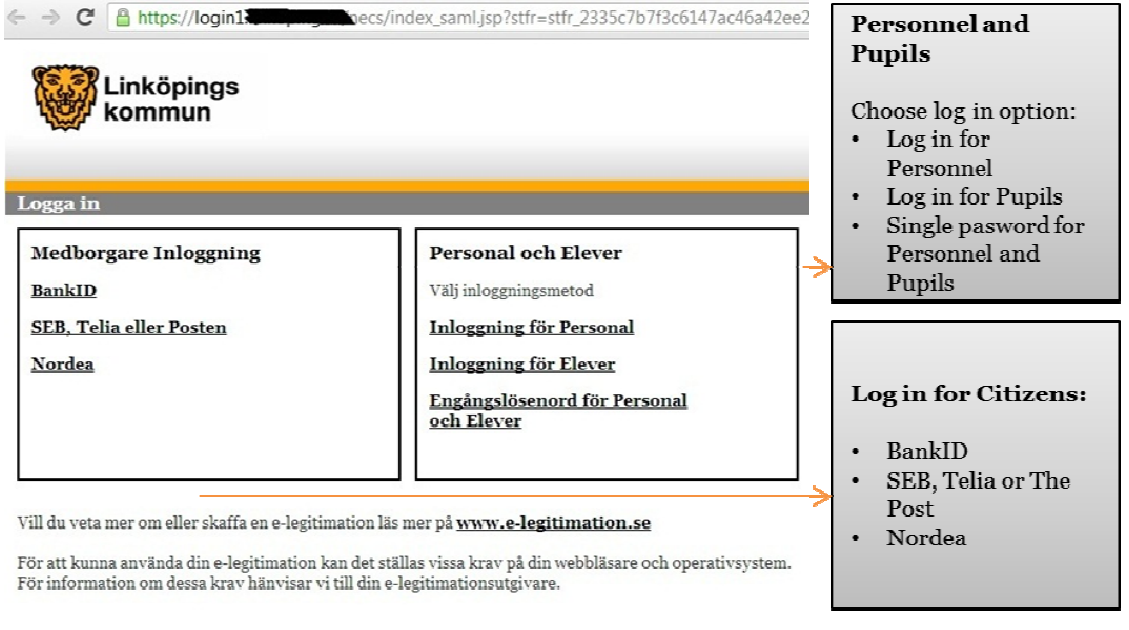
Figure 2. FRONTER log in snapshot